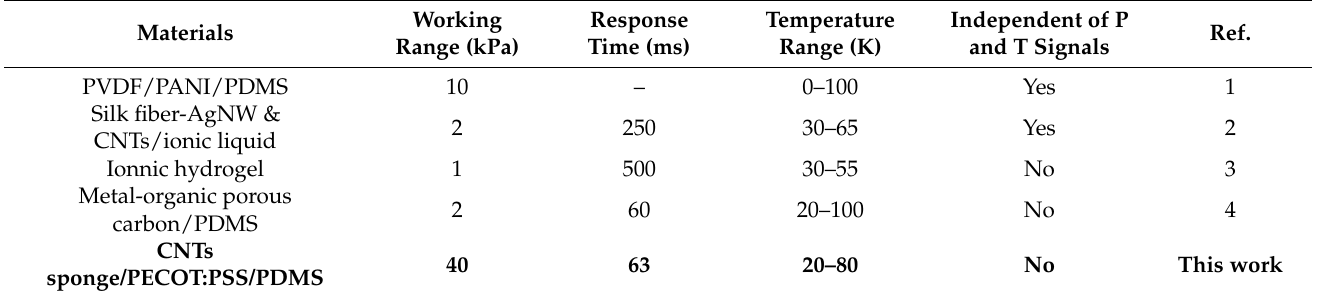
Table 1. A comparison with the previous work